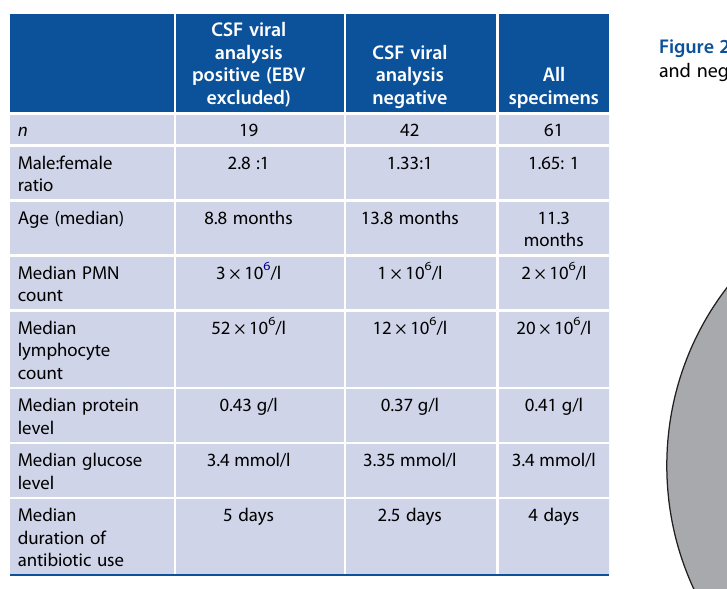
Table 2: Epidemiology of viral meningitis